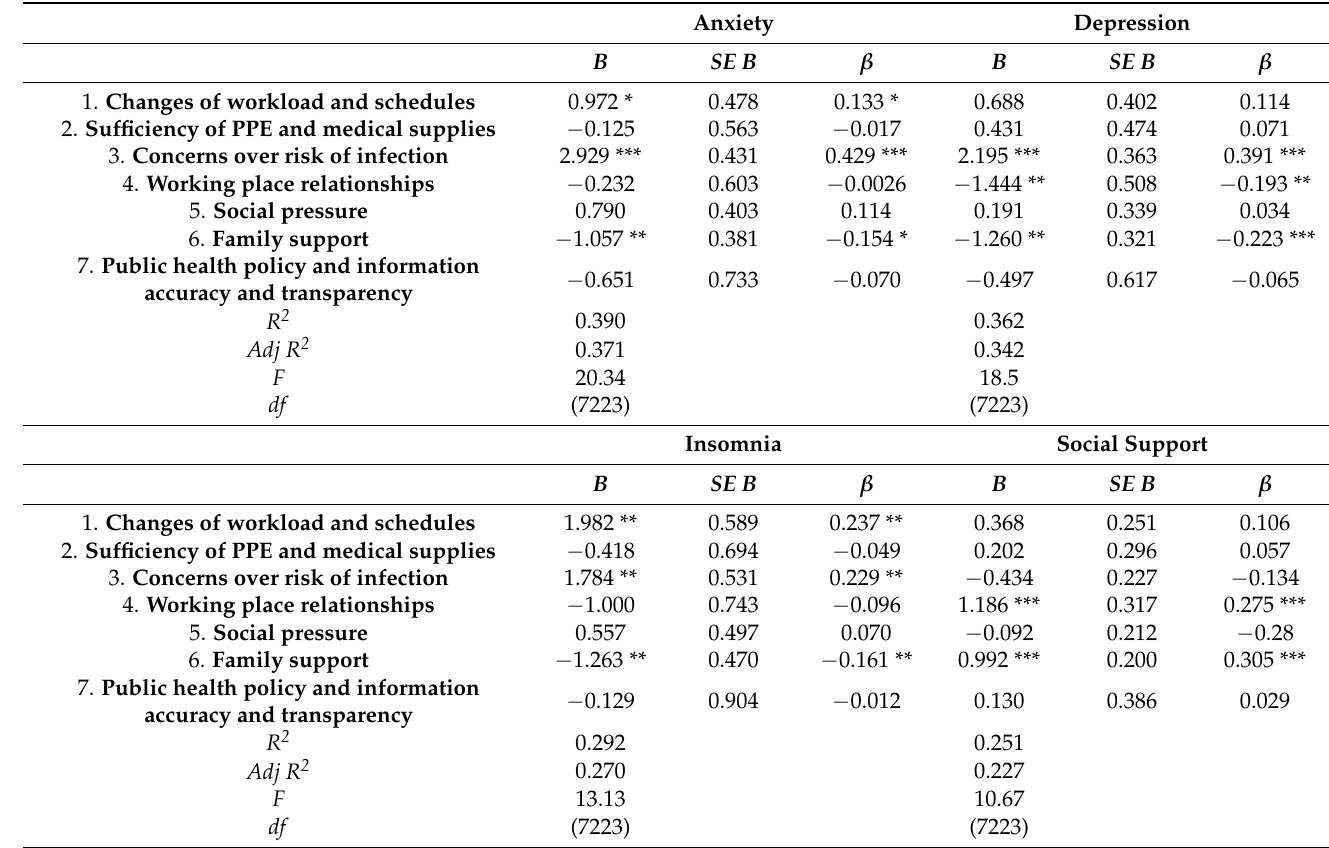
Table 7. Multiple linear regression analysis on extrinsic factors during second wave of